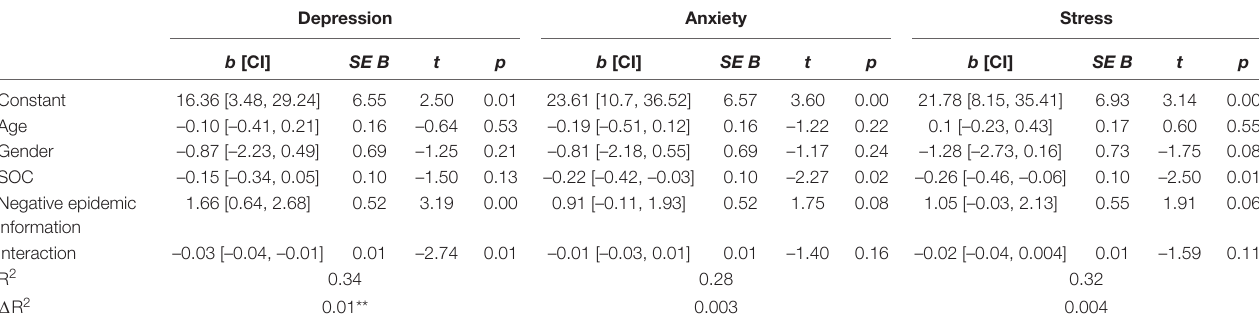
TABLE 3 | Hierarchical regression analyses of Negative epidemic information exposure on negative emotions ( N = 424). Depression Anxiety